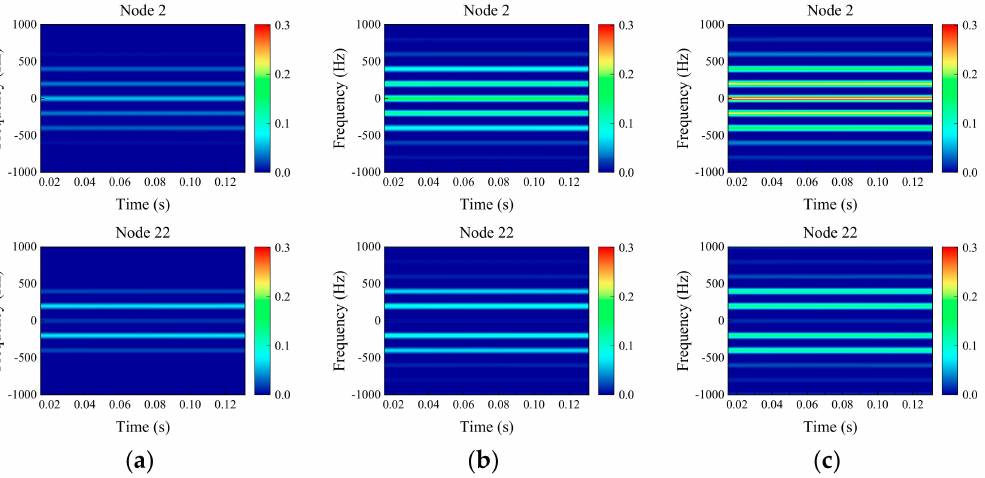
Figure 10. Time-frequency diagram of imbalanced and rubbing coupling faults: ( a ) value of imbalance 20 × 10 − 5 kg · m; ( b ) value of imbalance 100 × 10 − 5 kg · m; ( c ) value of imbalance 200 × 10 − 5 kg ·